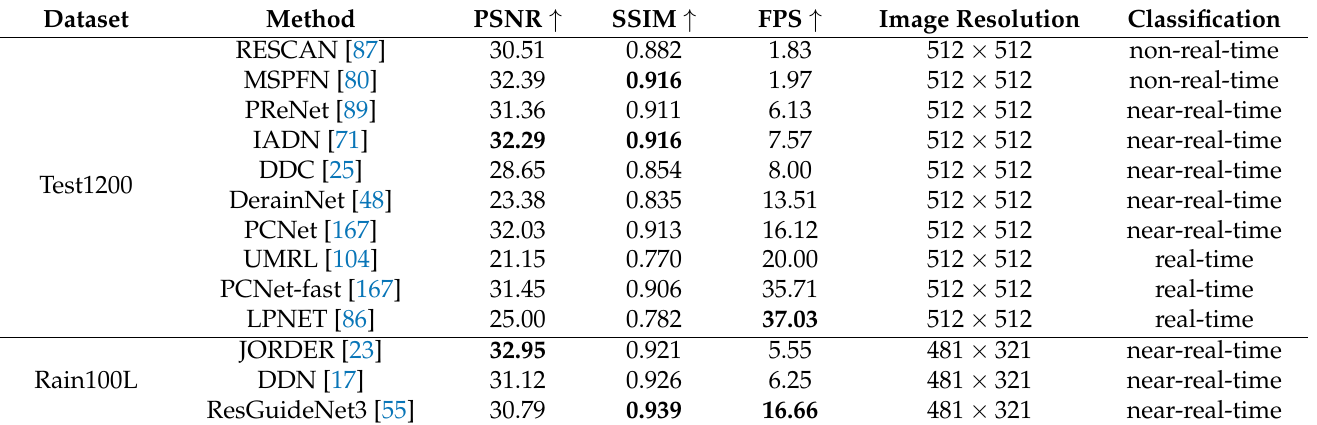
Table 7. Quantitative results of deraining methods along with their running time. ↑ means higher is better. In bold we indicate the best result for each